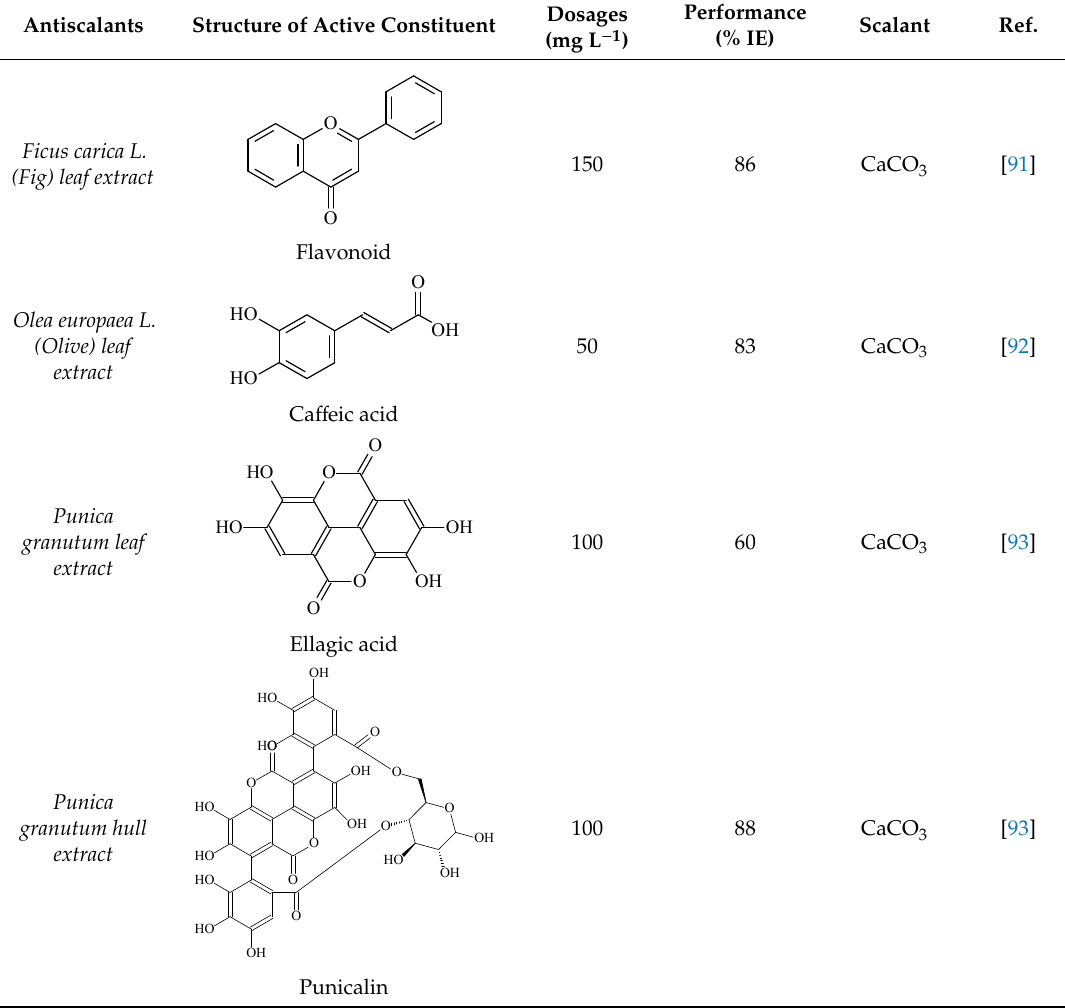
Table 3. Schematic chemical structural constituents of plant-derived extracts as scale inhibitors. Antiscalants Structure of Active Constituent Scalant Ficus carica L. (Fig)